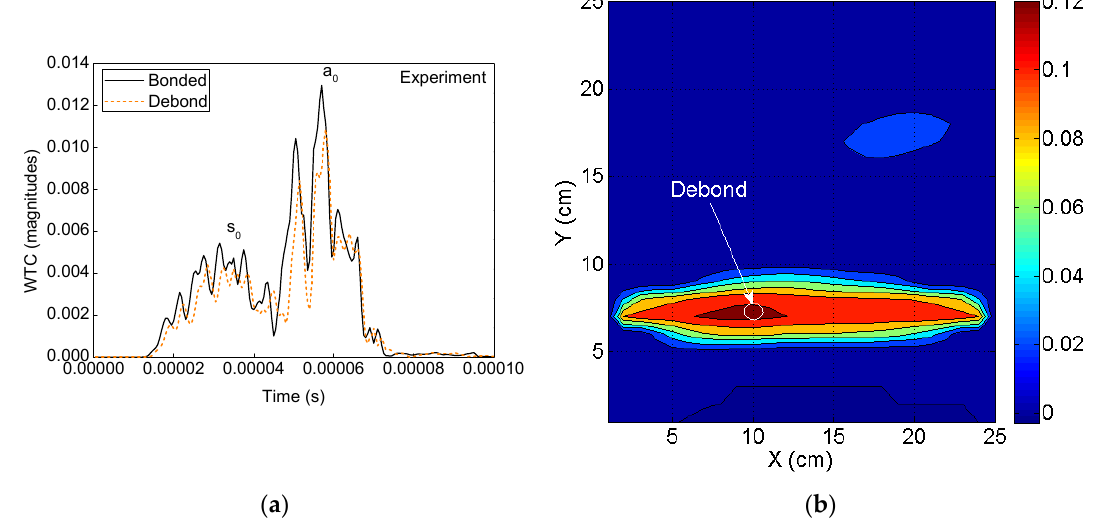
Figure 10. Experimental analysis: ( a ) A typical comparison of time domain WTs of the bonded and debond-influenced signals (Figure 9) and ( b ) debond index map showing the predicted debond location.